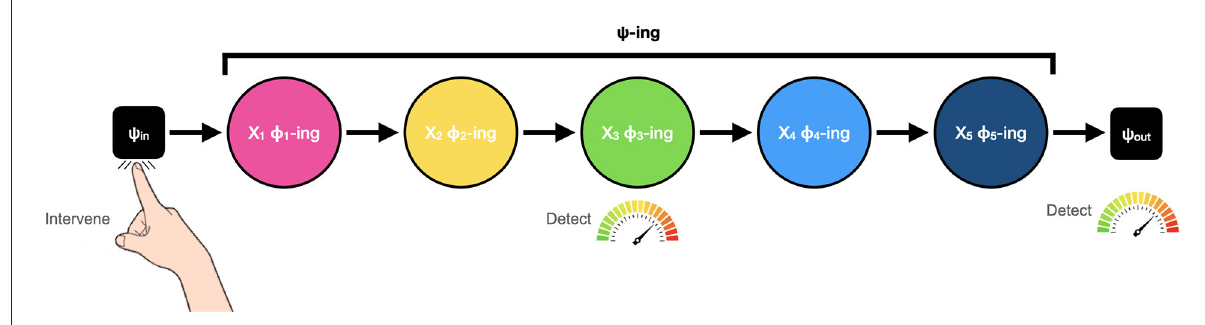
FIGURE2 Modified depiction of top-down experiments. Adapted from Craver et al.